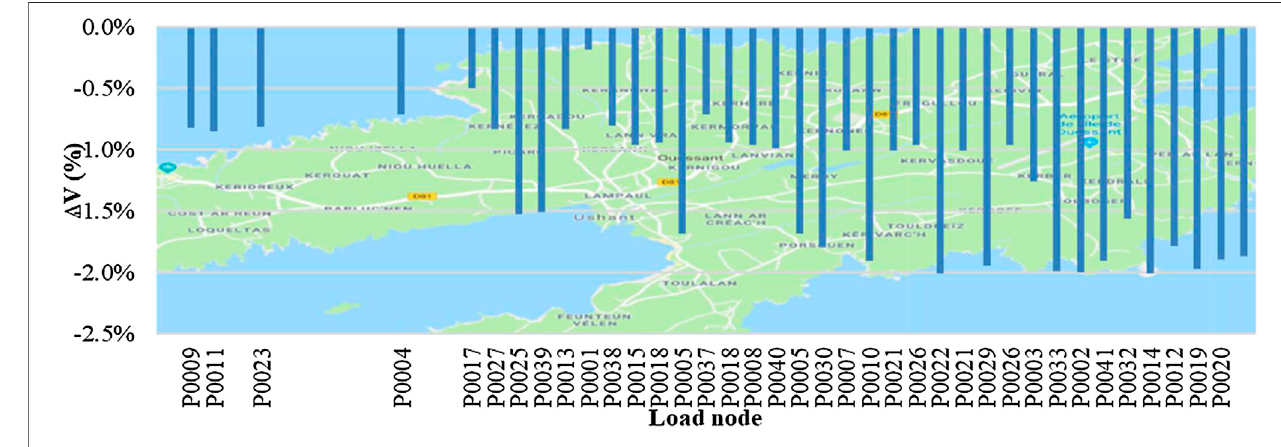
FIGURE 11 | Voltage drop under maximum demand.